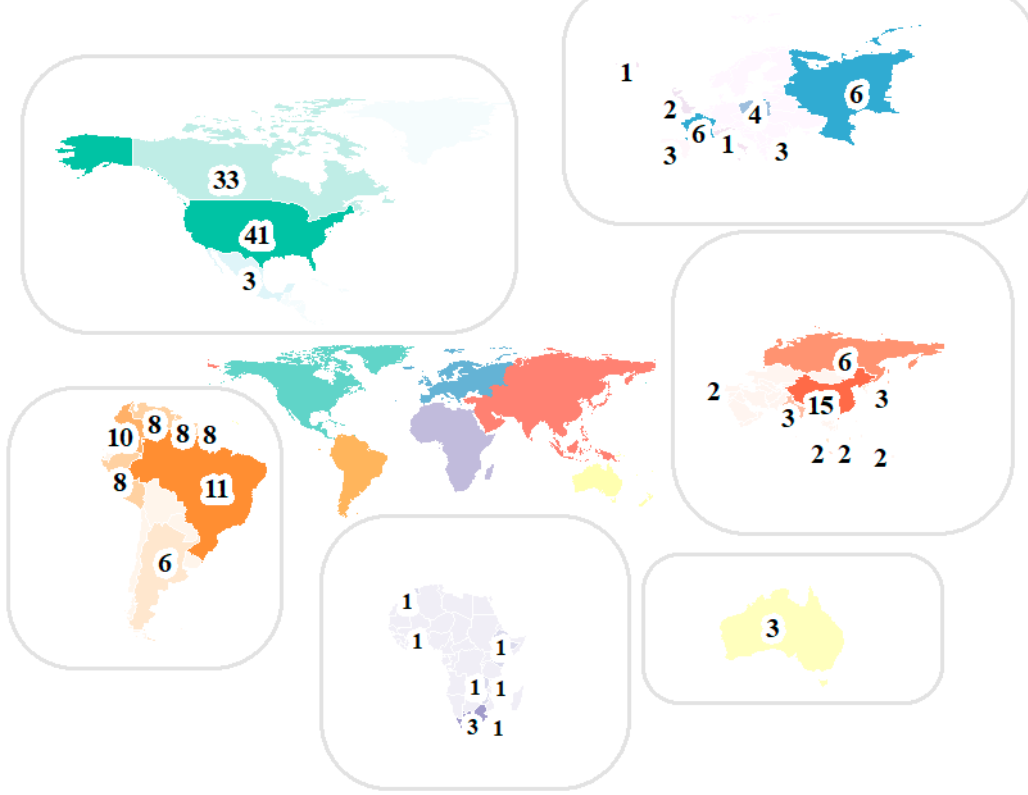
Figure 6. World map illustrating frequency of published articles per country.